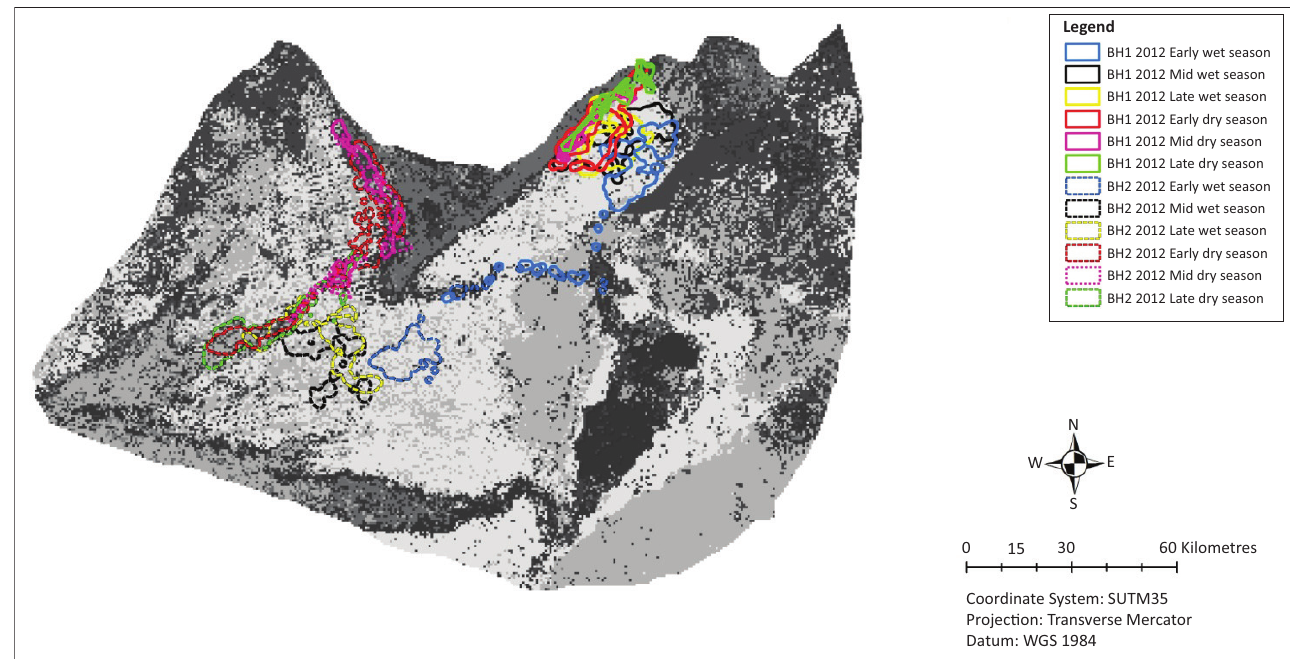
FIGURE 4: Movement patterns of buffalo 1 (BH1) and buffalo 2 (BH2) over the 2011/2012 annual cycle, in relation to